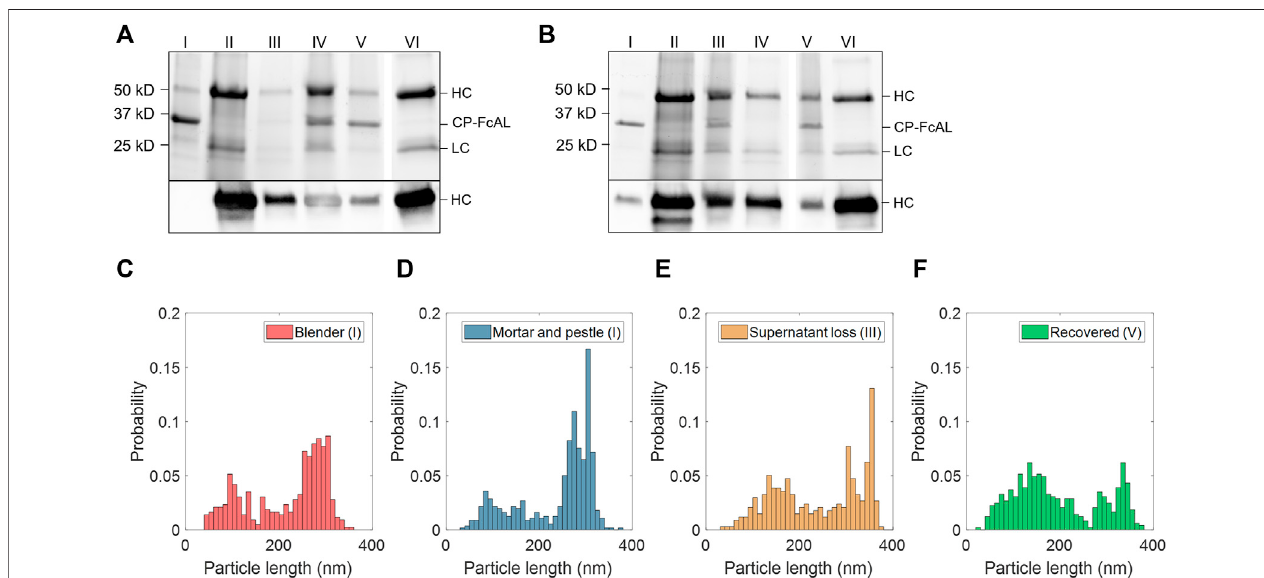
FIGURE 3 | Plant virus-based immunosorbent nanoparticle (VIN)-based capture and elution of human immunoglobulin G (hIgG) from crude solution over multiple use cycles. (A) VIN-based capture and elution using a sample of hIgG in crude N. benthamiana plant extract, and (B) a second capture and elution cycle of the VIN recovered after the fi rst use cycle. Lane de fi nitions: I — initial VIN added; II — initial target added; III — VIN/target supernatant (loss); IV — VIN/target pellet resuspended (capture) (2x); V — recovered VIN (2x); VI — recovered target (eluate) (5x). Gels are marked with band heights corresponding to VIN coat protein Fc-af fi nity ligand fusion (CP-FcAL) and hIgG heavy chain (HC) and light chain (LC) constituents. Particle length analysis of negative stain transmission electron microscope images for (C) blender-extracted VIN, (D) liquid nitrogen-assisted mortar and pestle-extracted VIN, (E) VIN in the supernatant lost during the VIN-target complex sedimentation stage,